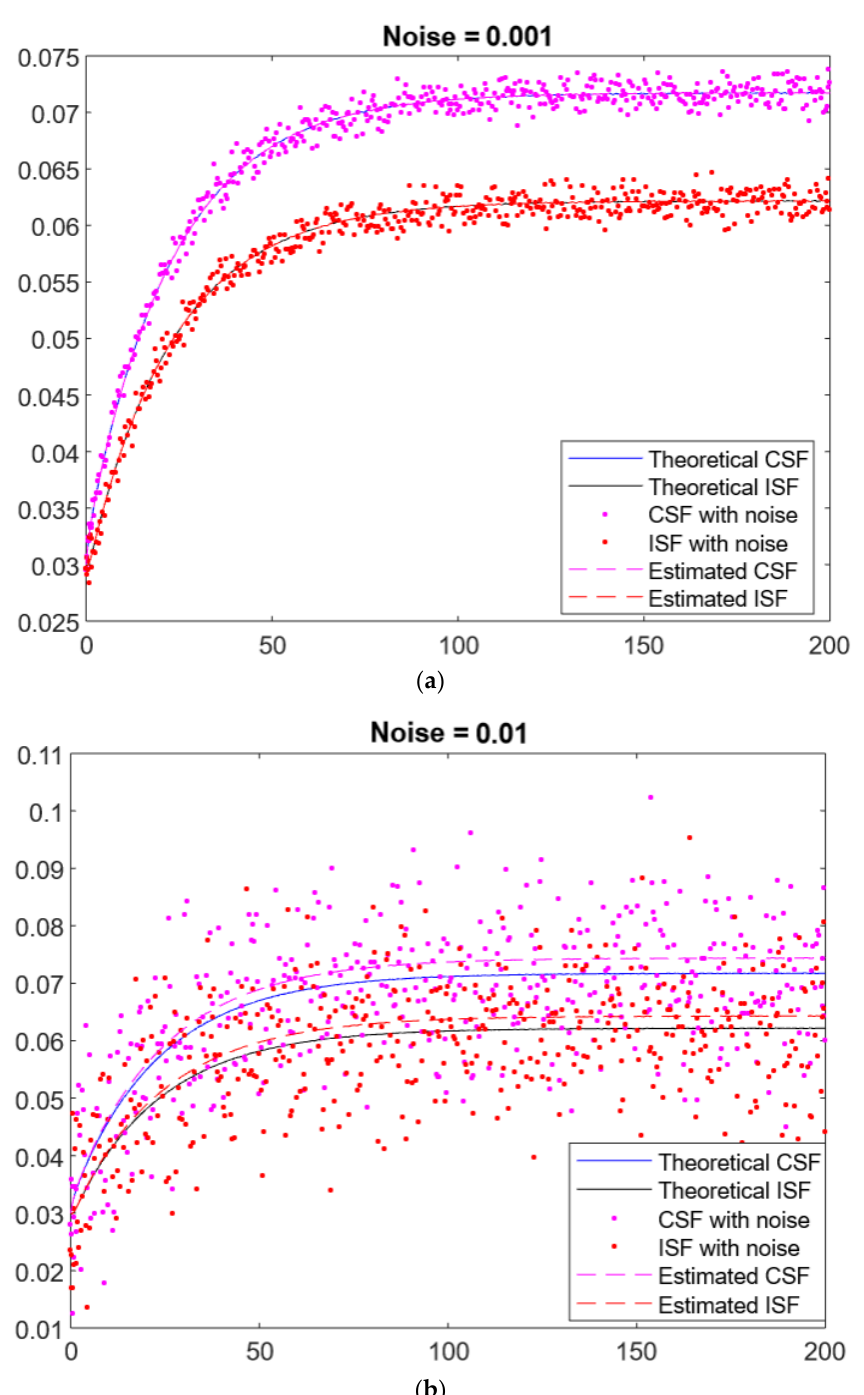
with ( a ) σ = 0.001 and ( b ) σ = 0.01. 21 and 13 ( 𝛼𝛼 𝑏𝑏 )